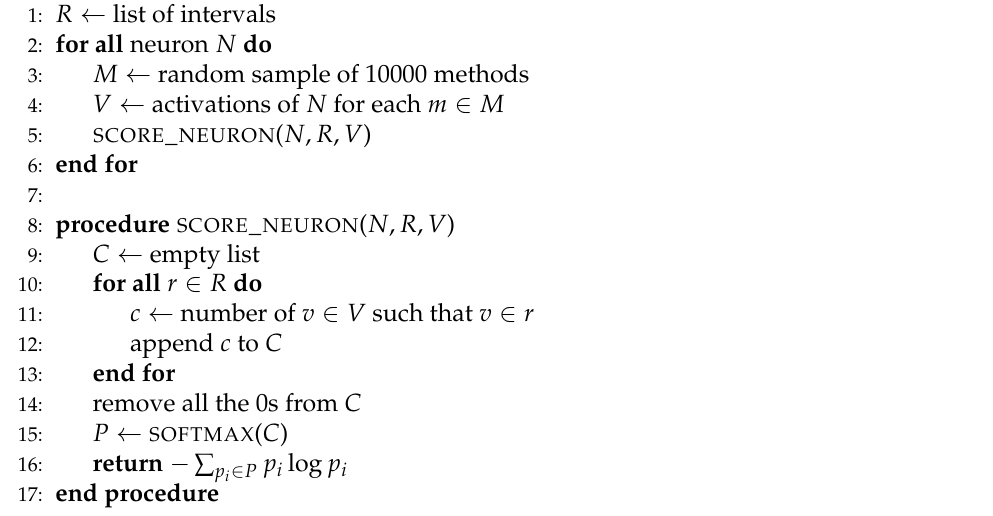
Algorithm 2 Algorithm for computing the entropy of each